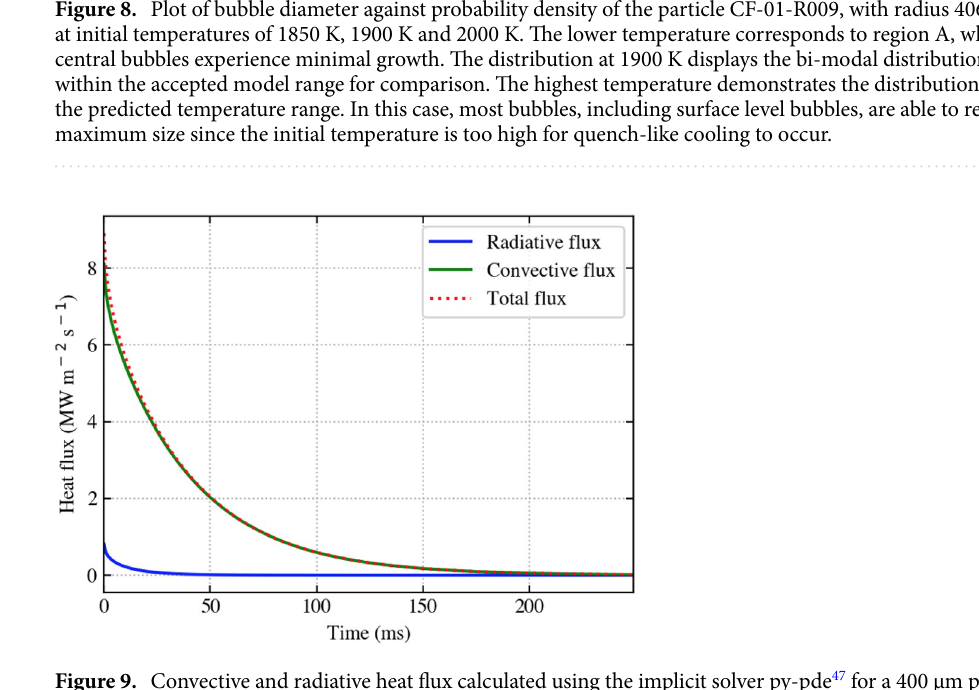
Figure 9. Convective and radiative heat flux calculated using the implicit solver py-pde 47 for a 400 μm